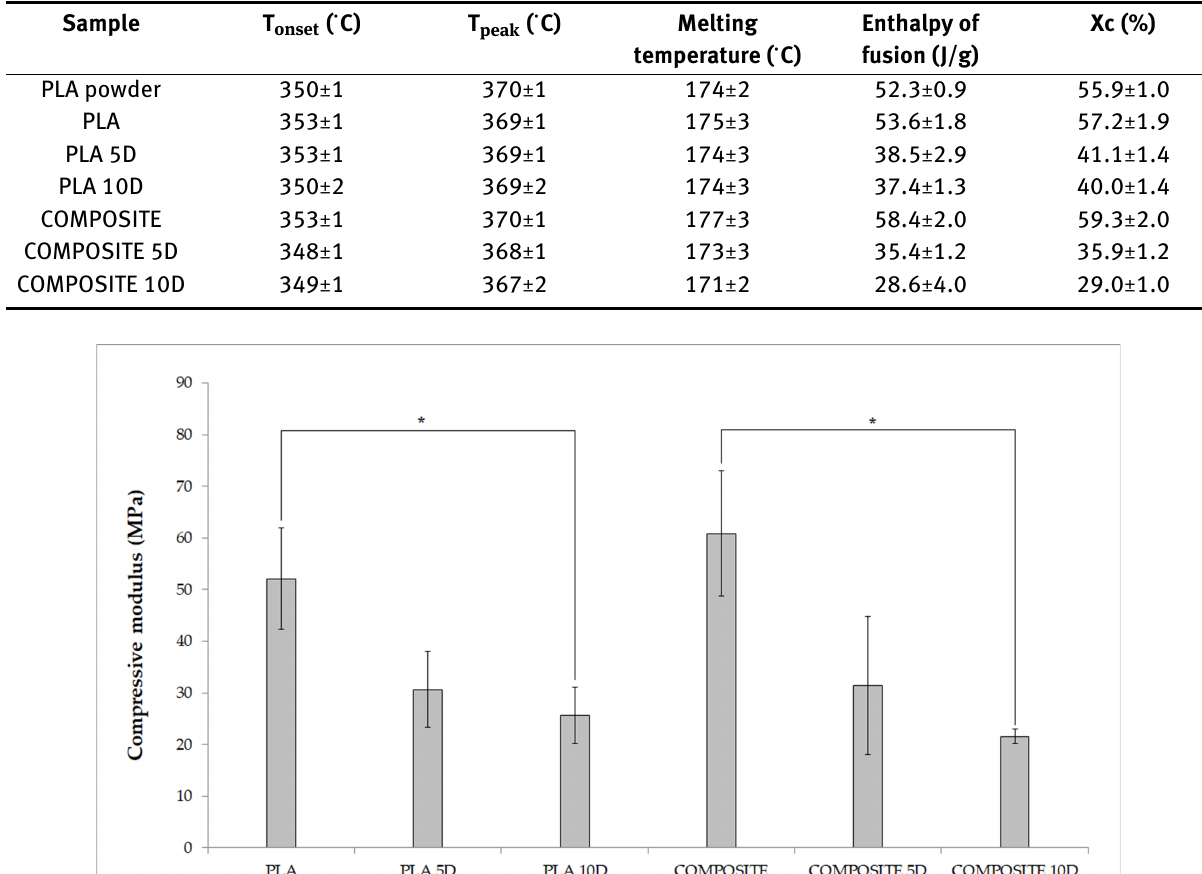
Table 2: Values determined from TGA and calorimetric analysis.